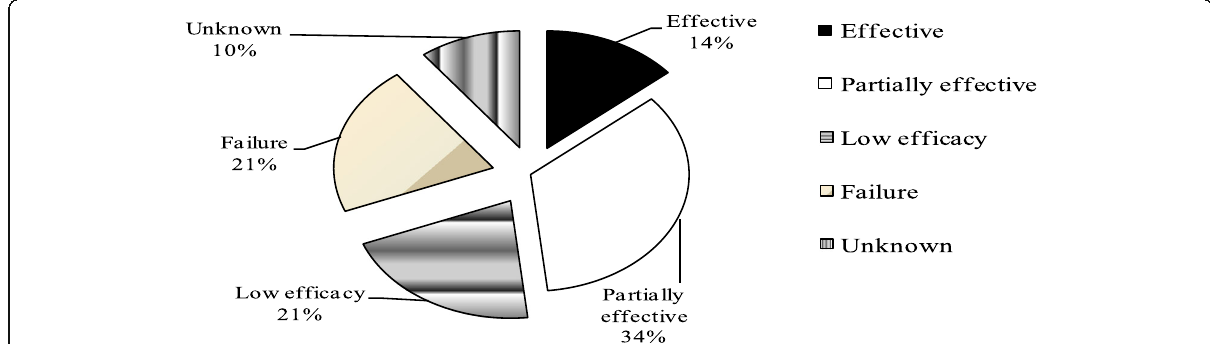
Fig. 6 Percentage of presence (%) of introduced species according to their efficacy in Moroccan citrus orchard ( N =